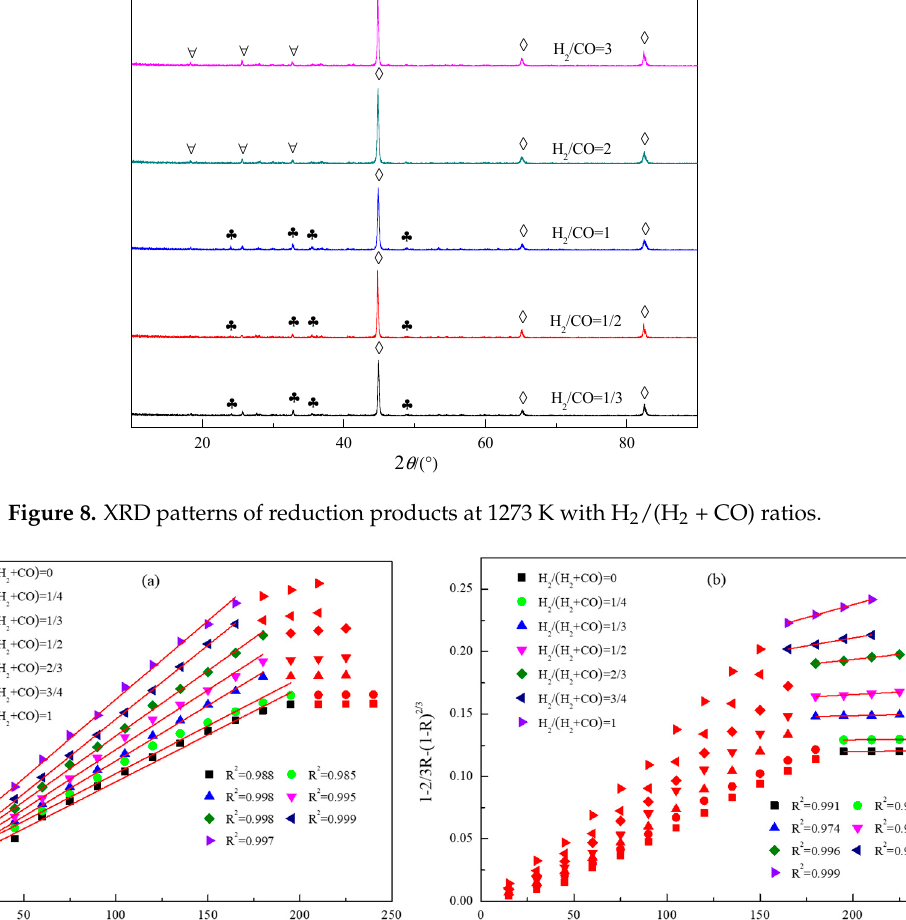
2 (cid:3118) 3 vs. (cid:2870) (cid:1844) − (1 − (cid:1844)) (cid:3119) vs. time. (cid:2871)